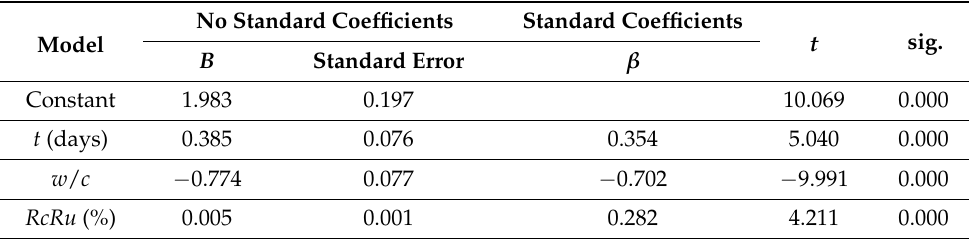
Table 9. Determination coefficients for UCS model. Dependent variable: 3